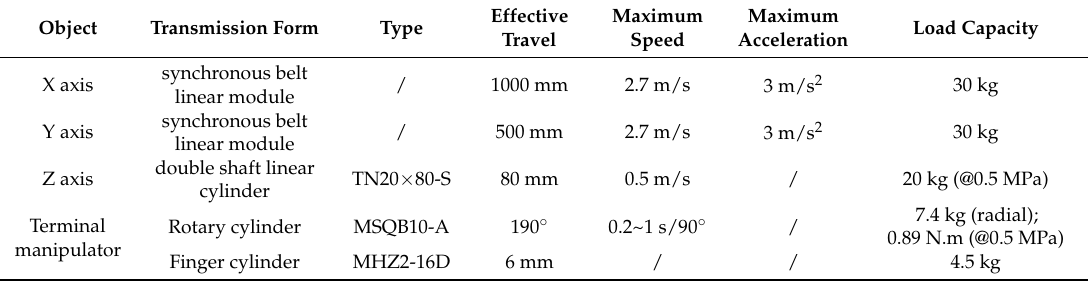
Table 4. Parameters of the robot body.